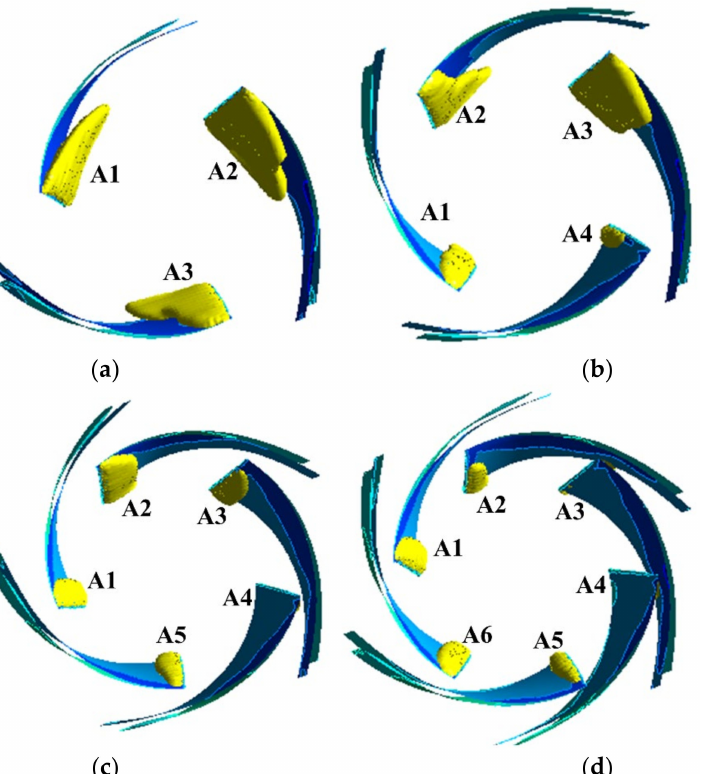
Figure 12. Cavitation volume distribution with different numbers of blades: ( a ) three-blade; ( b ) four- blade; ( c ) five-blade; ( d ) six-blade. Note: The setting angle of impeller blade inlet is 22 ◦